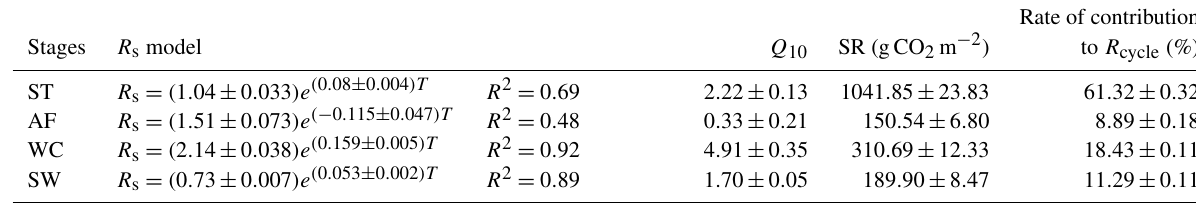
Table 4. The R s model, Q 10 value, and SR and its contribution to R cycle in different freeze–thaw stages.